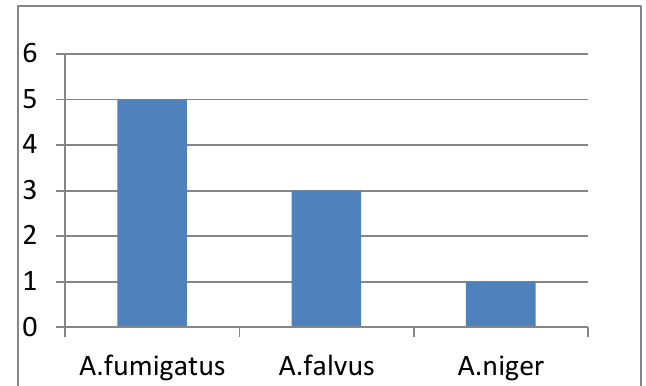
Figure 2 . Frequency of Aspergillus spp among the study population